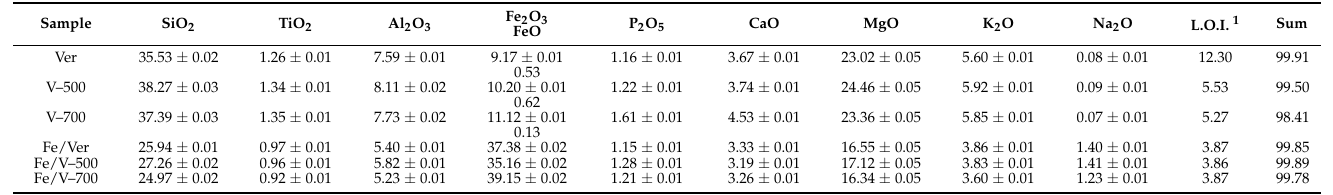
Table 1. Chemical XRF analysis (mass%) of vermiculites and α -Fe 2 O 3 nanoparticles/vermiculite composites and the statistical error with a confidence interval of 1 sigma.